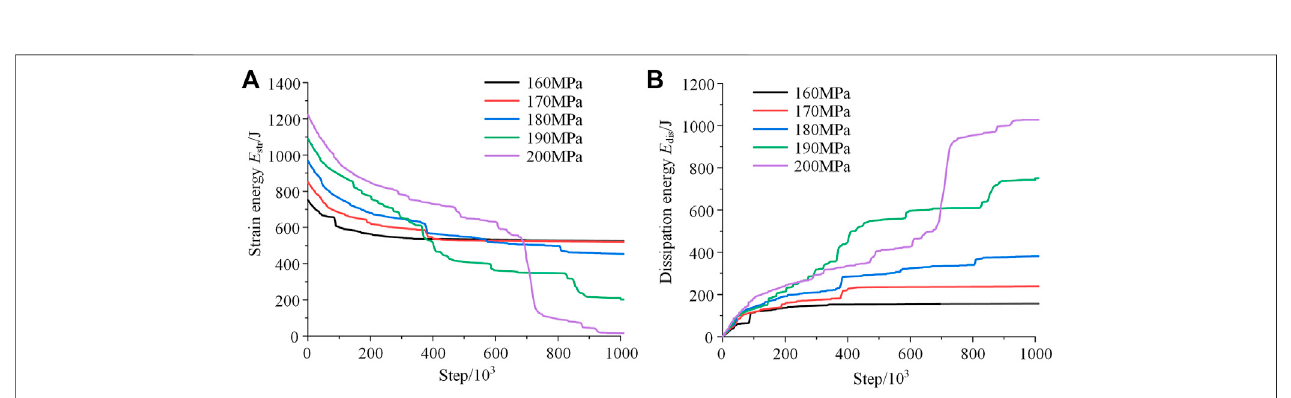
FIGURE 8 | (A) Energy release and (B) energy dissipation process of granite under different axial stress.